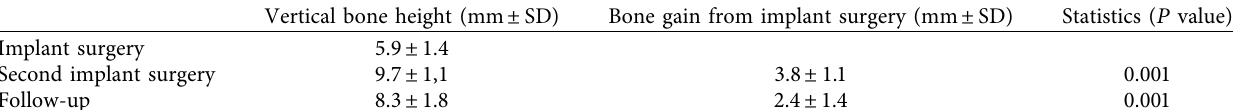
Table 2: Results from measurements of intrasinus bone formation.